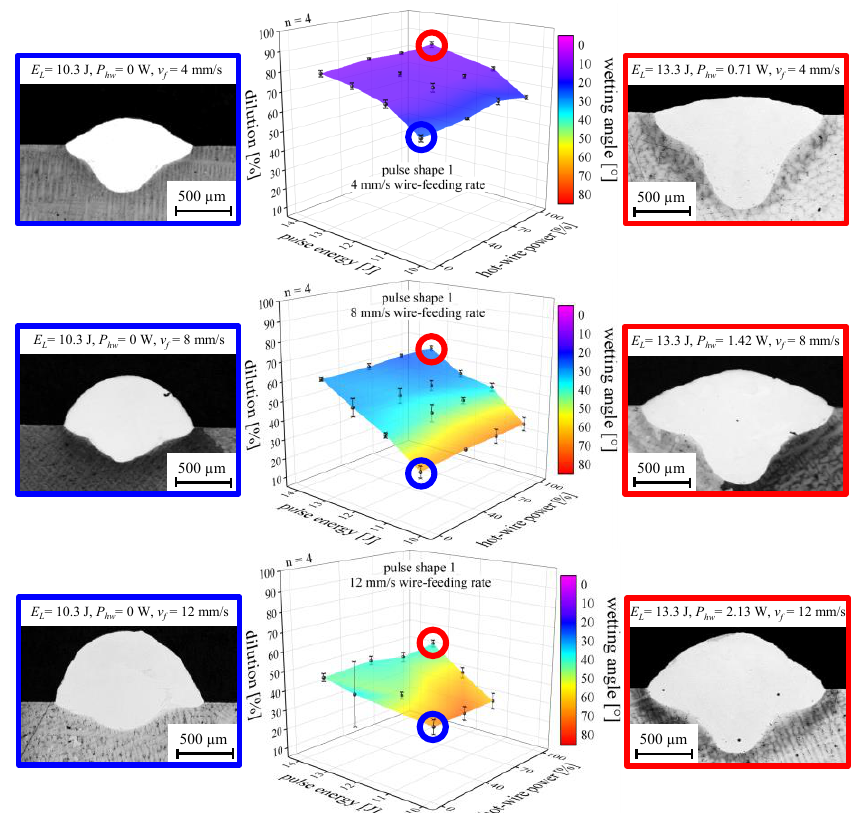
Figure 11. Dilution as function of pulse energy and hot-wire power for pulse shape 1 and wire-feeding rates of 4, 8 and 12 mm/s. Blue marked data points and corresponding micrographs belong to the lowest energy input (laser only), and red marked data points and corresponding micrographs belong to the highest energy input (laser and hot-wire). The hot-wire power is given in percent in the diagrams and with absolute values in the header of the micrographs.